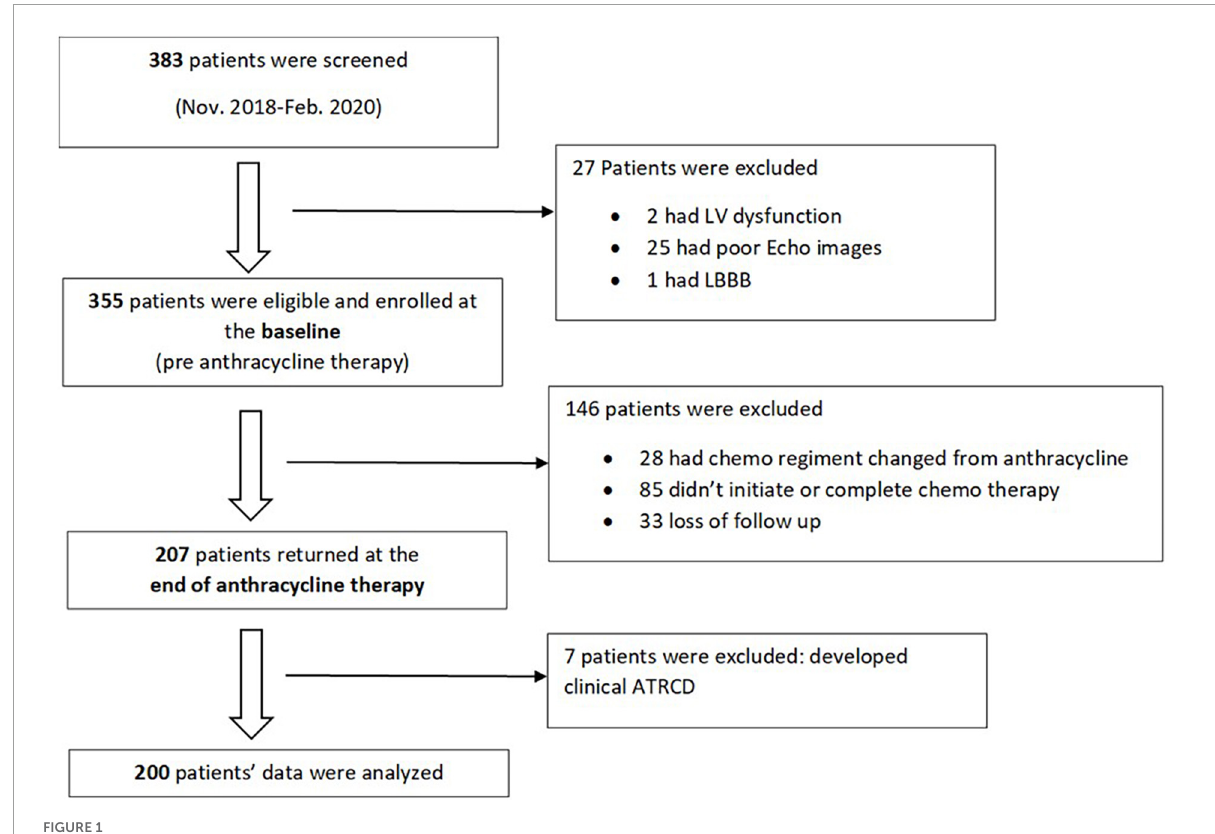
FIGURE1 Patients’ flow chart.